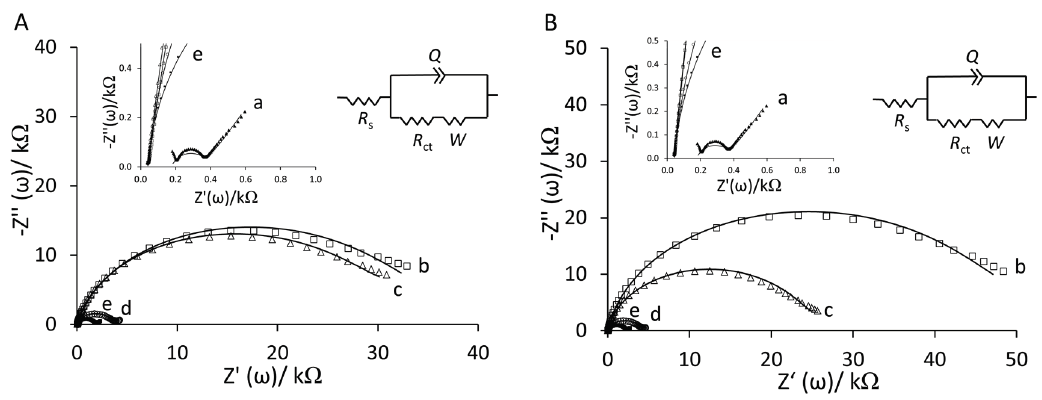
Figure 3. Nyquist plots of the step-wise surface fabrication of ( A ) YNGRT-Au and ( B ) VLGXE-Au: (a) bare Au, (b) Lip-NHS, (c) peptide, (d) ethanolamine and (e) 2-mercaptoethanol (inset: equivalent circuit used for fitting impedance